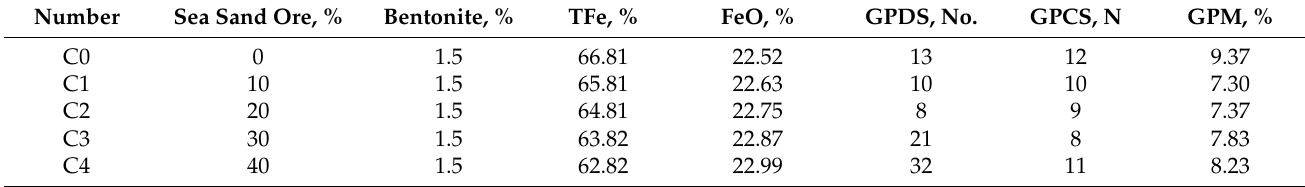
Table 5. Performance of green pellets with different the dosage of sea sand